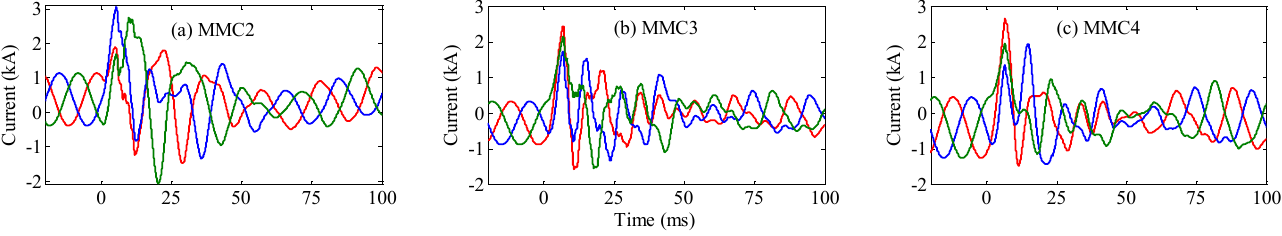
Fig. 12. The arm currents of MMCs in presence of UCBs (overcurrent-based method) (a) MMC2, (b) MMC3, (c)